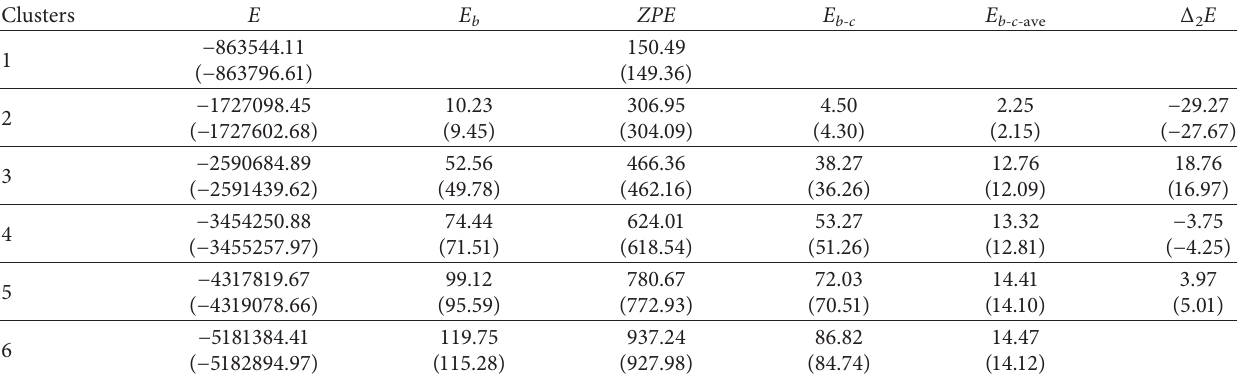
Table 3: Total energies (E), zero point energy ( ZPE ), uncorrected binding energies ( E binding energy ( E b-c -ave ), and second-order energy difference ( Δ 2 E ) (unit: kJ · mol − 1 ) a . Clusters